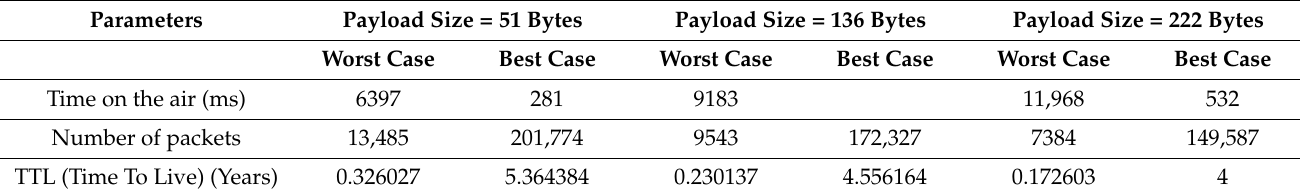
Table 12. Battery lifetime in the case of [19] Security-Enhanced Option (SEO) for different message sizes (126 bytes overhead due to